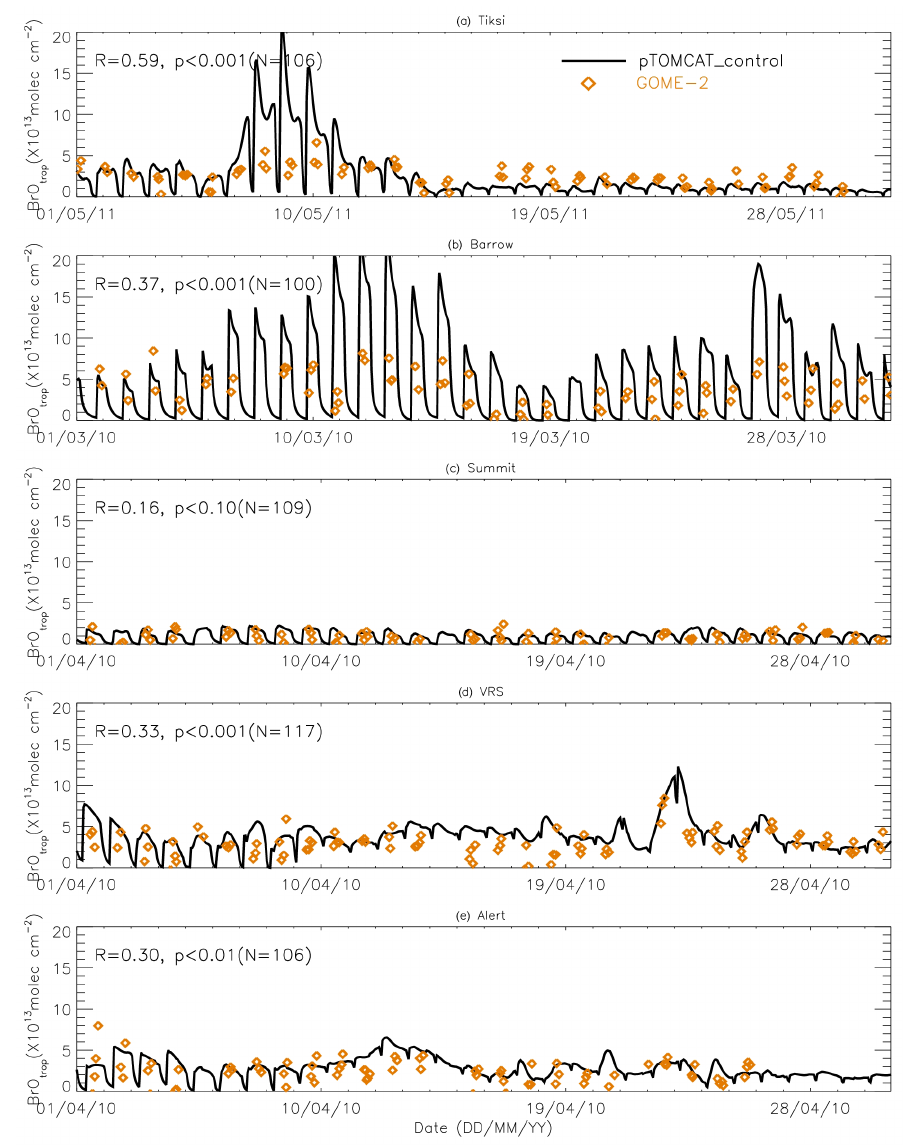
Figure 9. Time series of tropospheric BrO column from GOME-2 (orange diamond symbols) and pTOMCAT_control run BrO (black line). The correlation coefficient R and statistical significance level p at each site are